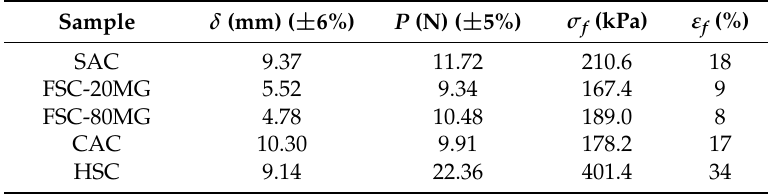
Table 4. Characteristic parameters from three-point flexure